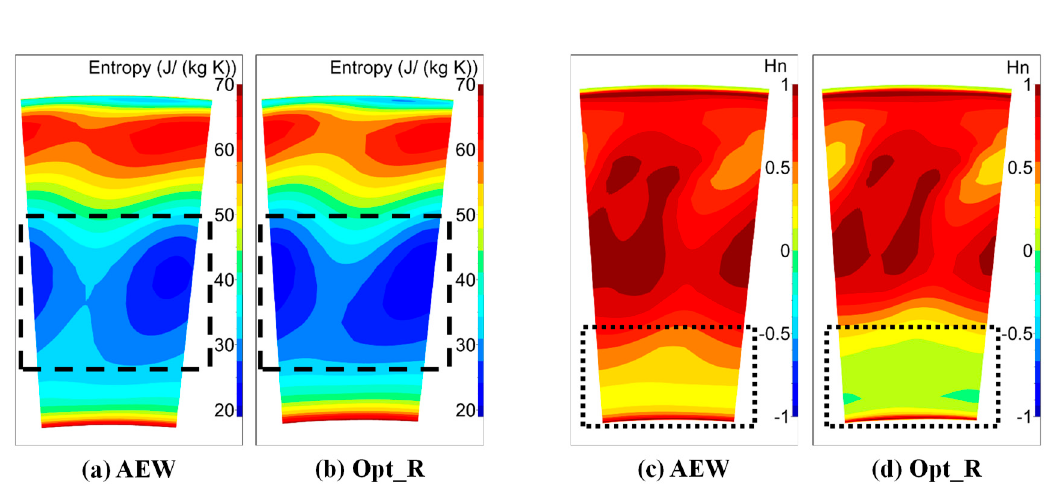
Figure 15. ( a – d ) Comparisons of contours of entropy and helicity at the rotor Figure 15. ( a–d ) Comparisons of contours of entropy and helicity at the rotor exit.